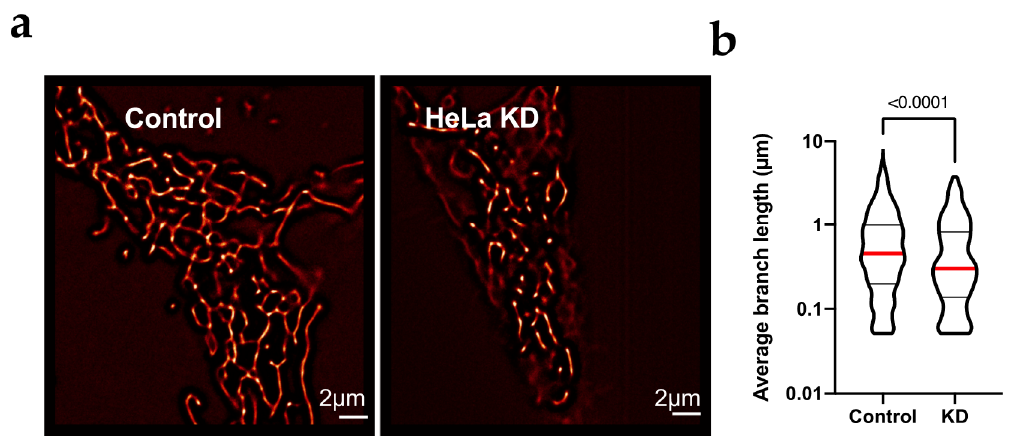
Figure 3. HeLa KD cells show mitochondrial fragmentation. ( a ) For detailed structure analysis, stacks of 100 images were analyzed by SRFF in HeLa and HeLa KD cells; representative examples are shown. ( b ) Average branch length in HeLa cells was larger then in HeLa KD cells. The median value is indicated by a red line and the number indicates the value of p obtained by non-parametric Mann-Whitney test since the limit in resolution renders the distributions not normal.